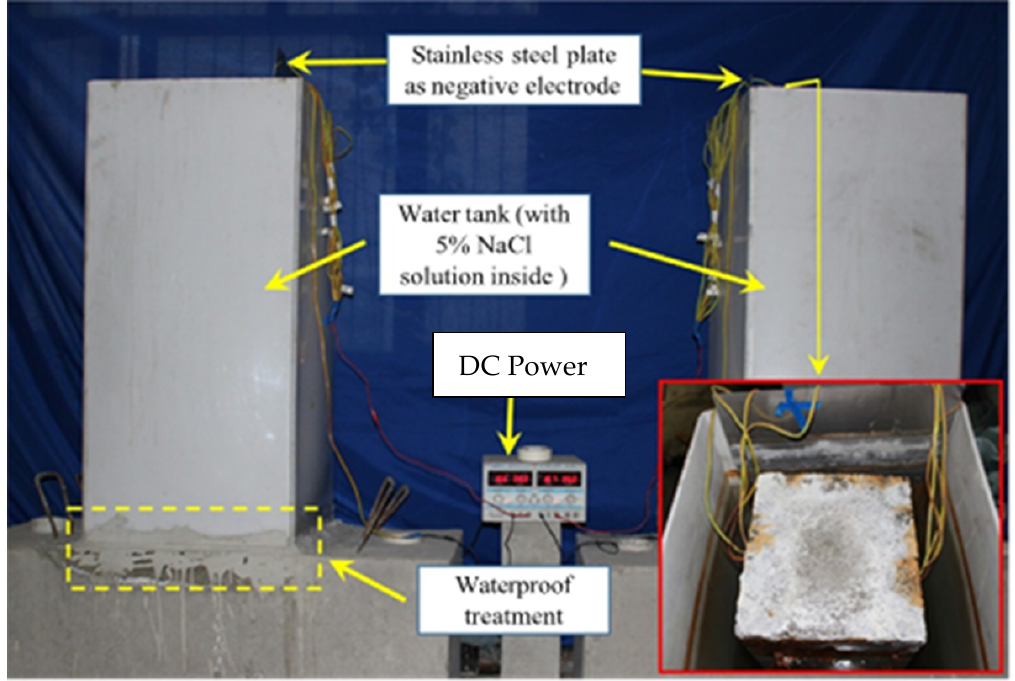
Figure 7. ECE mechanism for inducing corrosion in RC members. Reproduced with permission from [96], Elsevier, 2020.